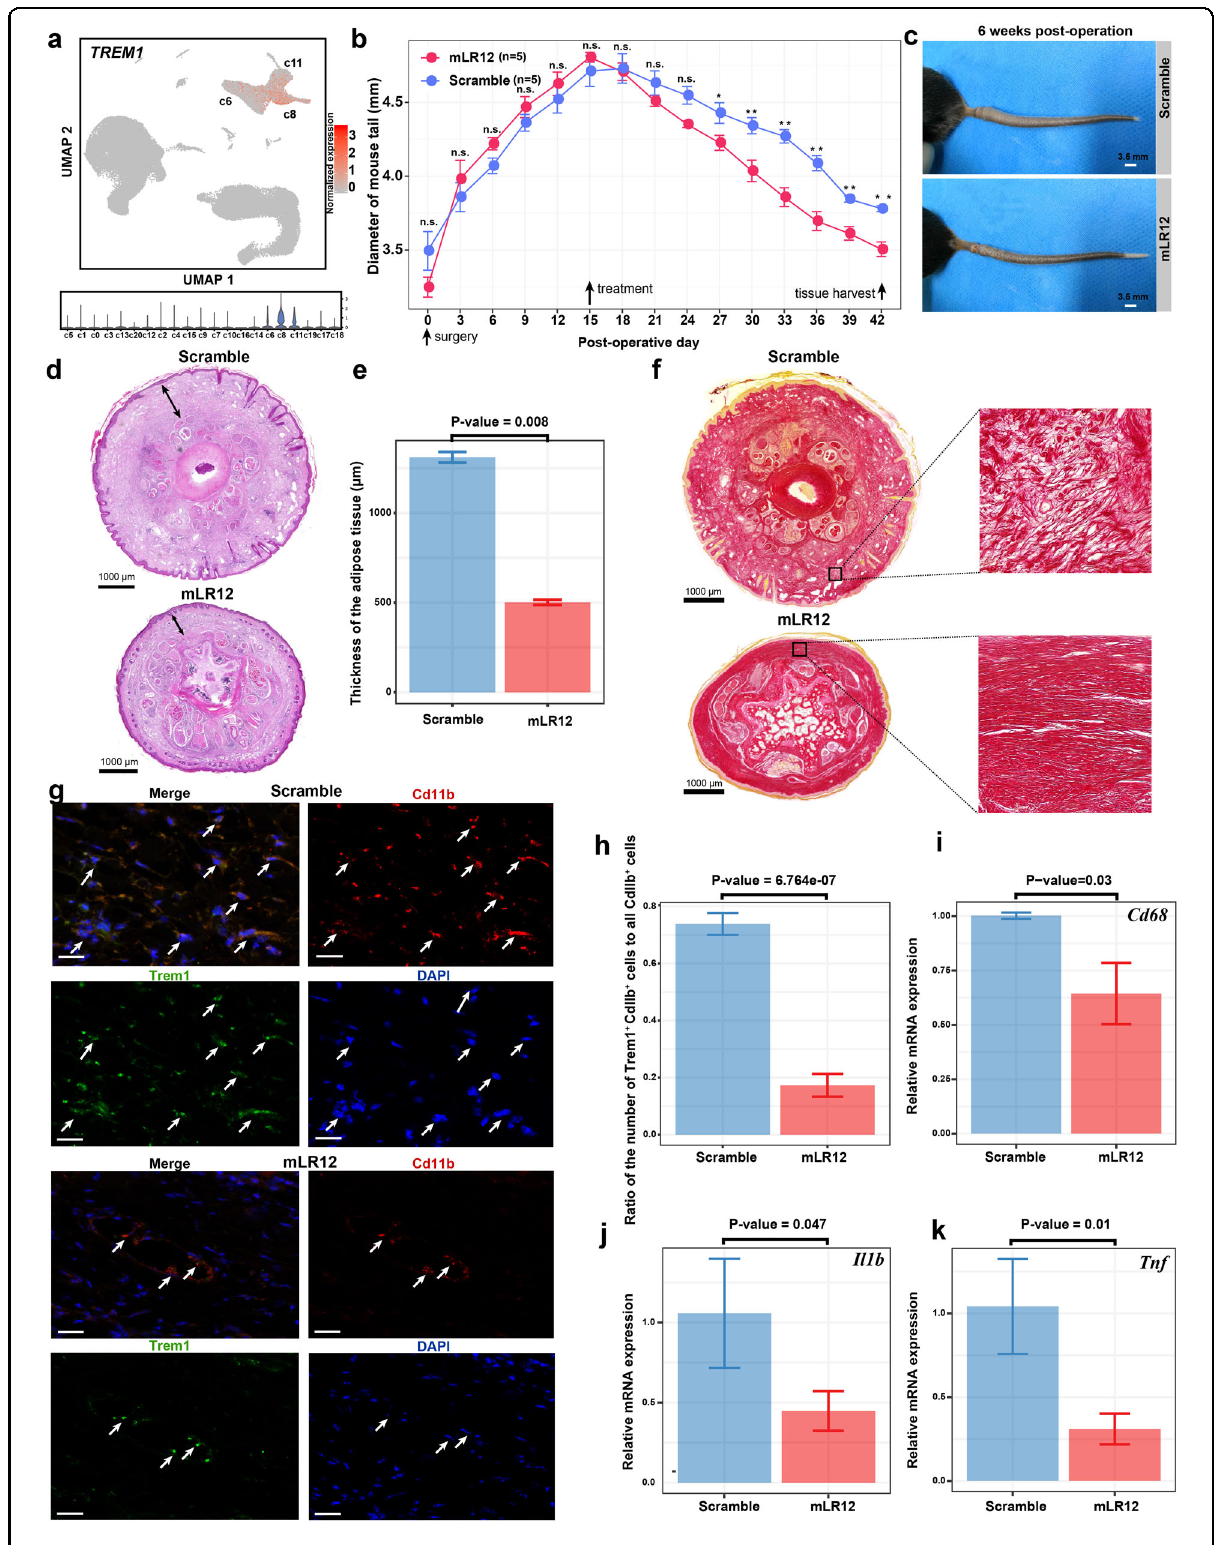
Fig. 6 (See legend on next